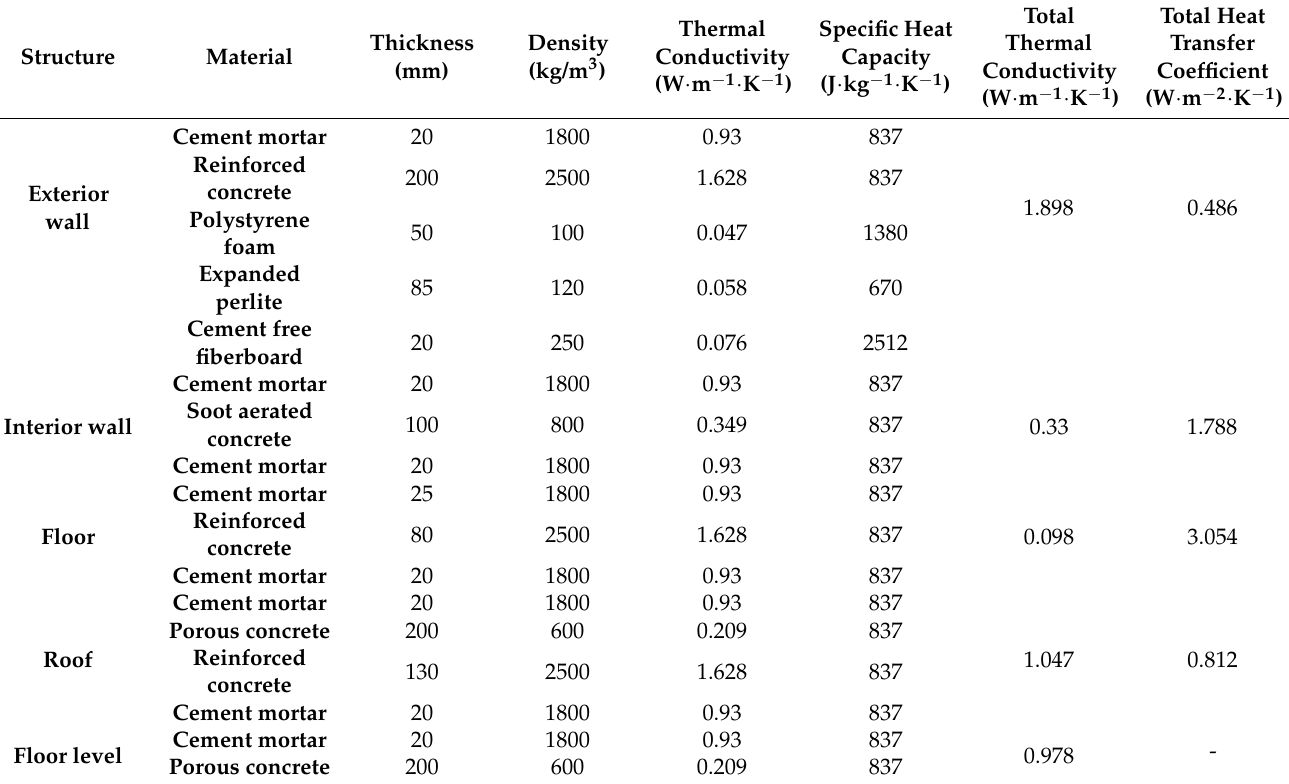
Table 16. Parameters of building envelope in Beijing.